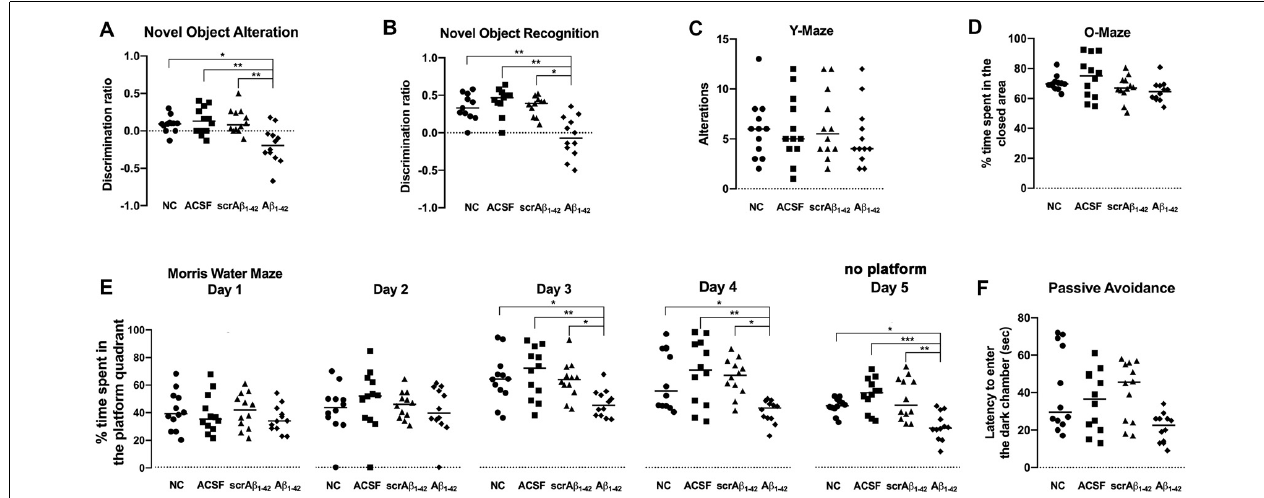
FIGURE 9 | A β 1–42 -injected mice showed long-term spatial memory impairment revealed by the novel object alteration ( A , performed on days 7, 8), novel object recognition ( B , performed on days 11, 12), and Morris Water Maze ( E , performed on days 20–24) tests. Short-term spatial memory assessed by the Y maze showed no significant difference in A β 1–42 -injected mice compared with controls ( C , performed on day 15). Non-spatial memory remained unchanged in A β 1–42 -injected mice compared with controls ( F , performed on day 27), and A β 1–42 and/or the injection itself did not produce any anxiogenic effect ( D , performed on day 17). Scatter plot showing all of the data values used with the median (Kruskal-Wallis test; * p < 0.05; ** p < 0.01, *** p < 0.001, n = 12).